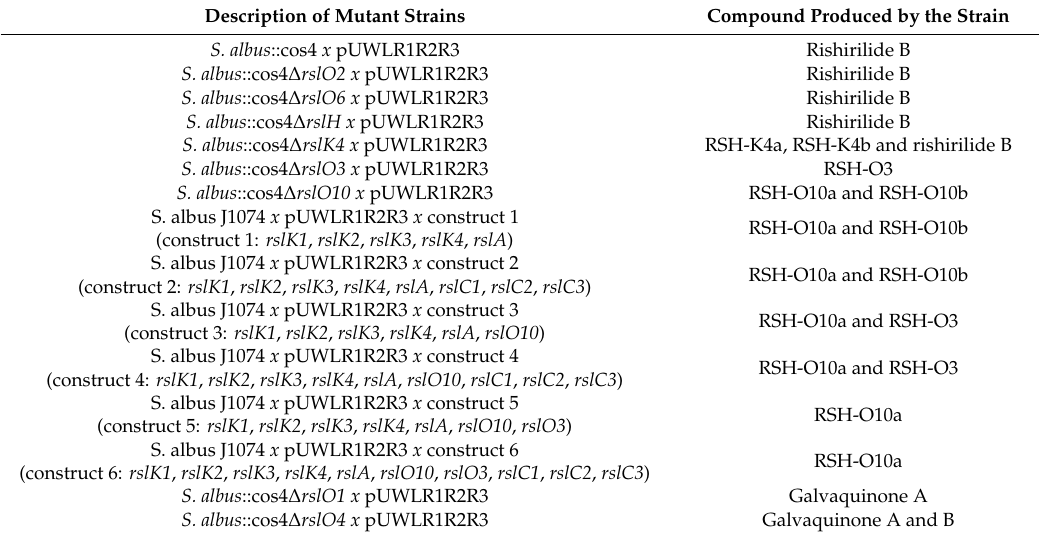
Table 1. Strains generated during this study and major compounds produced by the